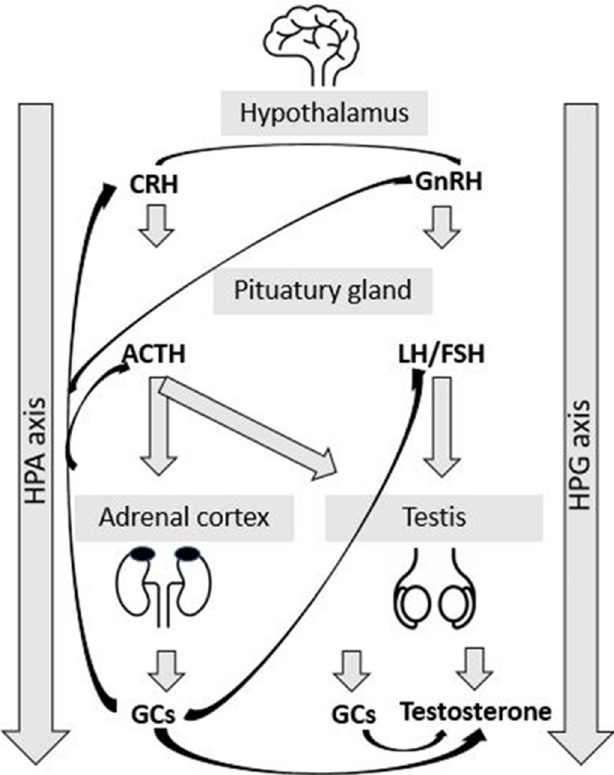
Figure 1. Schematic representation of hypothalamic–pituitary–adrenal (HPA) and hypothalamic– pituitary–gonadal (HPG) axis. Black arrows represent inhibitory effect of each hormone. CRH: cor- ticotropin-releasing hormone, GnRH: gonadotropin-releasing hormone, ACTH: adrenocortico- tropic hormone, LH: luteinizing hormone, FSH: follicle-stimulating hormone, and GCs: glucocorti- coids .